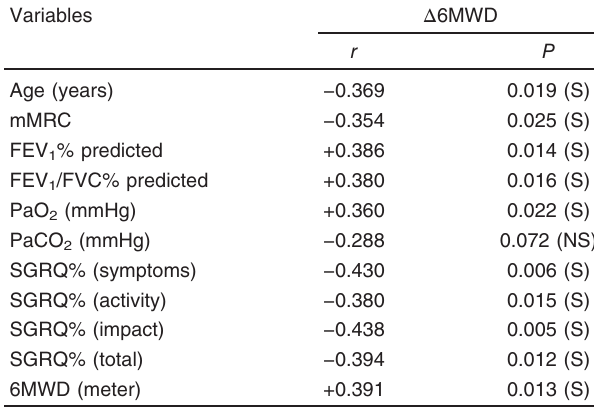
Table 7 Correlation between baseline variables and change (increase) in 6min walk distance after pulmonary